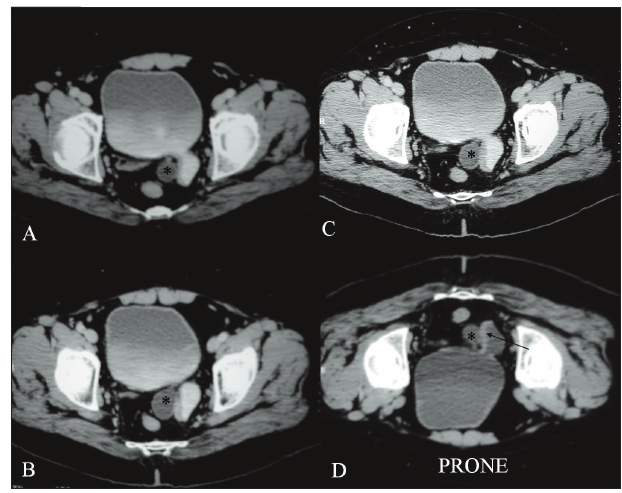
Fig. 1. Axial post-contrast CT scans obtained in (a - c) supine and (d) prone positions show minimal thickening and enhancement of the medial wall of a left-sided narrow neck bladder diverticulum. The asterisk indicates the dilated lower left